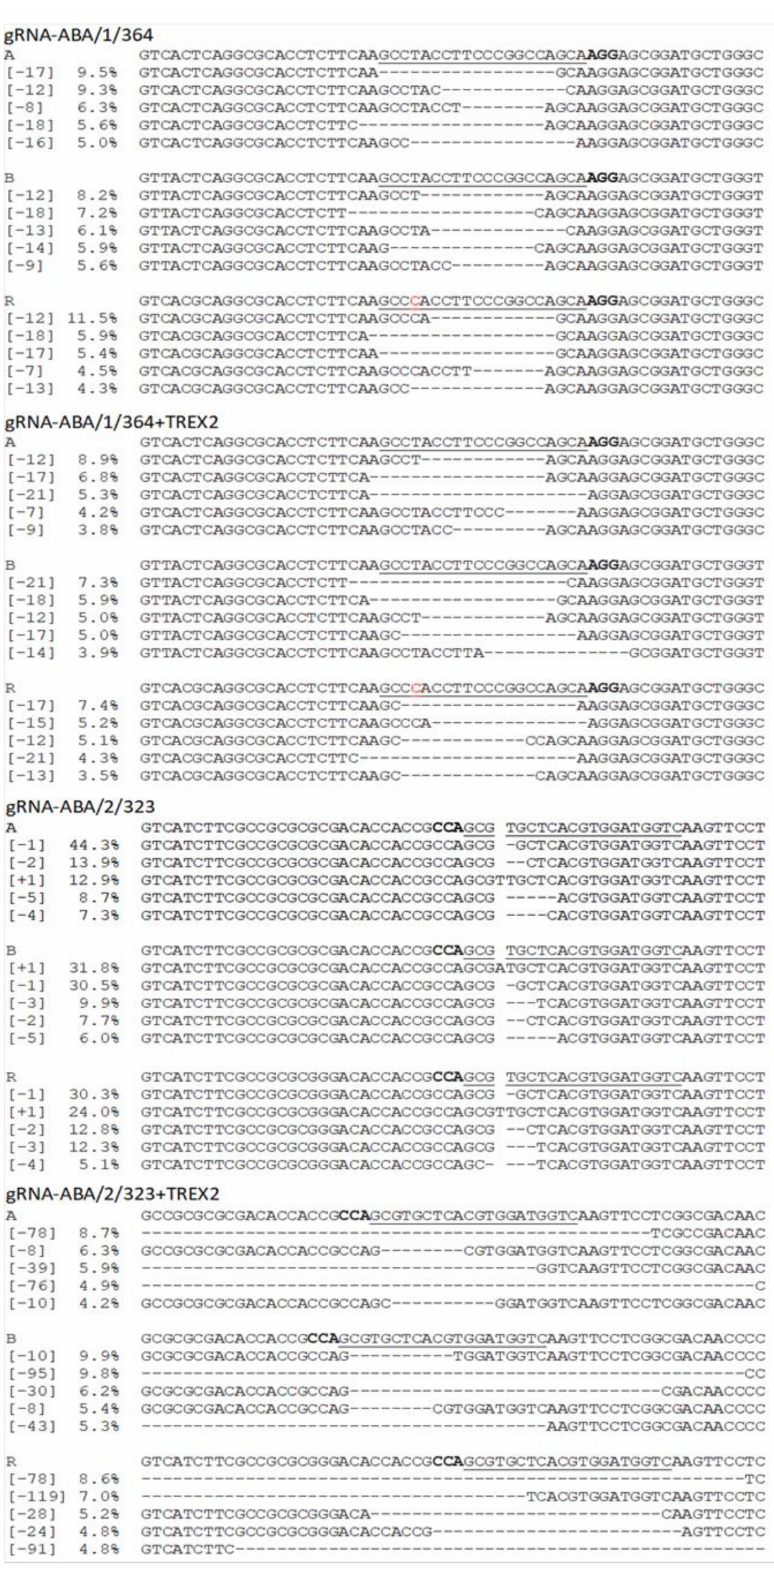
Figure 4. Relative frequency of the most abundant mutations among changes induced on each subgenome of triticale protoplast by transient expression of cas9/gRNA-ABA/1/364 and cas9/gRNA- ABA/2/323 constructs, lacking or containing TREX2 enhancer. PAM motif bolded; target motif underlined. SNP present in the target motif ABA/1/364 of the R genome is marked in